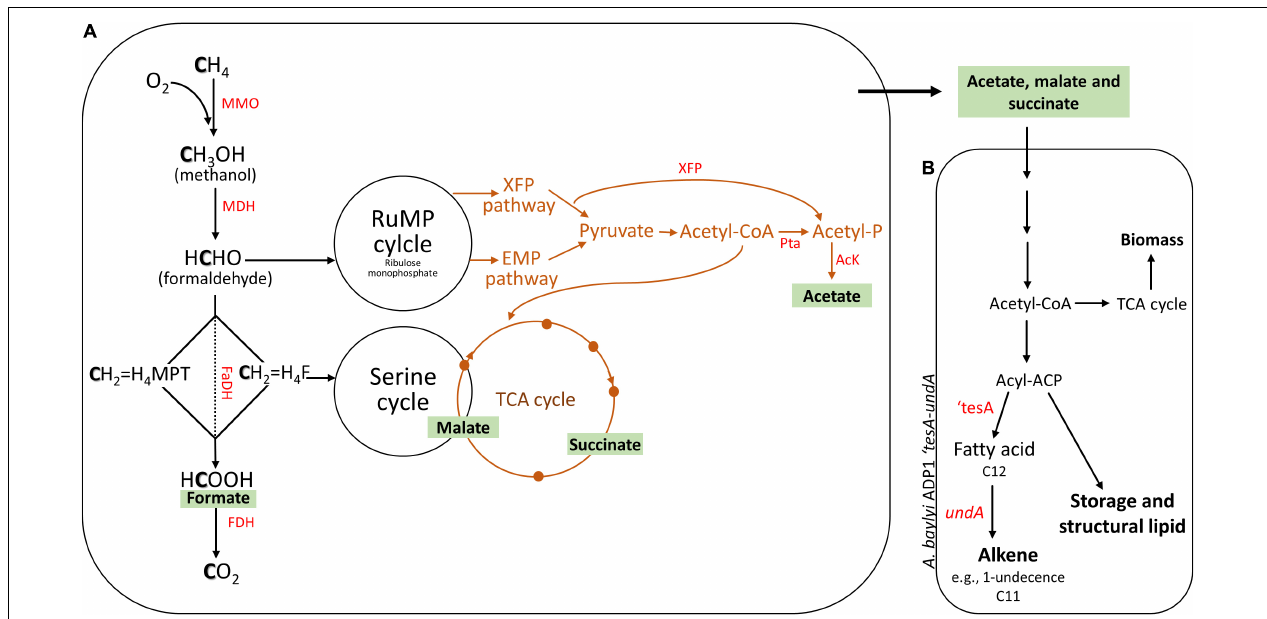
FIGURE 1 | Principle of a two-stage bacterial process. The estimated pathway of the production of various organic acids could occur in methanotrophs (A) . Organic acid-rich spent medium was fed to the engineered Acinetobacter baylyi ADP1 for alkene production (B) . Aerobic CH 4 oxidation pathway in Type I (RuMP cycle) and Type II (Serine cycle) methanotrophs (black arrows) and the possible pathway of CH 4 oxidation under O 2 -limiting conditions via glycolysis-based CH 4 fermentation mode (brown line). RuMP, ribulose monophosphate; EMP, Embden–Meyerhof–Parnas; TCA, tricarboxylic acid; MMO, methane monooxygenase; MDH, methanol dehydrogenase; FaDH, formaldehyde dehydrogenase; H 4 F, tetrahydrofolate pathway; H 4 MPT, tetrahydromethanopterin pathway; FDH, formate dehydrogenase; PTa, phosphate acetyltransferase; AcK, acetate kinase; XFP, phosphoketolase xylulose 5-phosphate/fructose 6-phosphate phosphoketolase; ‘ tesA , thioesterase; undA , decarboxylase. Modified from Gilman et al. (2017) and Luo et al. (2019).